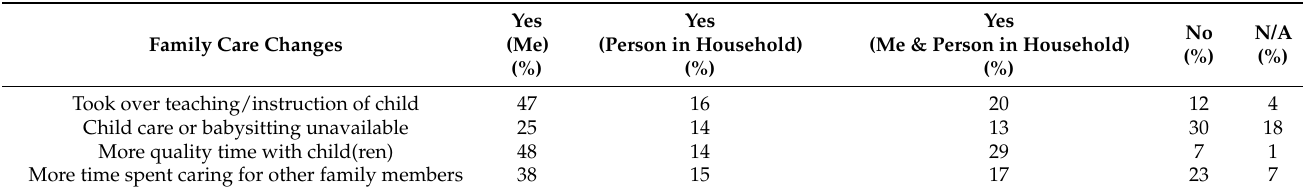
Table 3. Parent-reported impacts of the COVID-19 pandemic on child-care, schooling, and care of other family members ( n = 1000). Family Care Changes